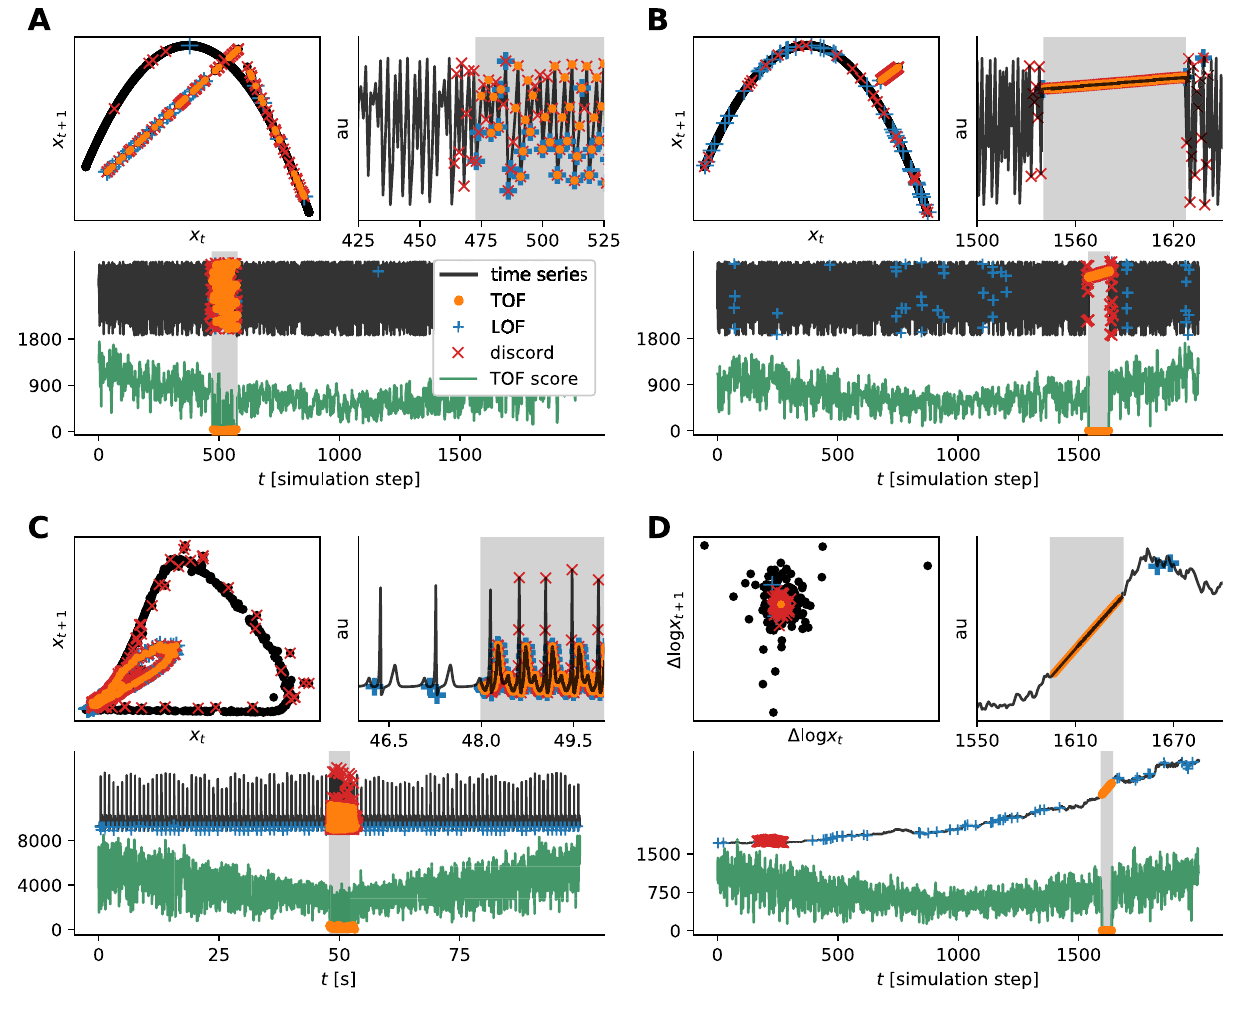
Figure 2. Detection examples on simulated time series with anomalies of different kinds. ( A ) Logistic map time series with tent-map anomaly. ( B ) Logistic map time series with linear anomaly. ( C ) Simulated ECG time series with tachycardia. ( D ) Random walk time series with linear anomaly, where TOF was measured on the discrete-time log derivative ( (cid:31) logx t ). Each subplot shows an example time series of the simulations (black) in arbitrary units and in three forms: Top left the return map, which is the results of the 2D time delay embedding and defines the dynamics of the system or its 2D projection. Bottom: Full length of the simulated time series (black) and the corresponding TOF values (green). Shaded areas show anomalous sections. Top right: Zoom to the onset of the anomaly. In all graphs, the outliers detected by TOF, LOF, and Keogh’s brute force discord detection algorithms are marked by orange dots, blue plus, and red x signs respectively. While anomalies form clear outliers on A and B, D shows an example where the unique event is clearly not an outlier, but it is located in the center of the distribution. All the three algorithms detected the example anomaly well in case A, TOF, and discord detected well the anomalies in B and C cases, but only TOF was able to detect all the four anomaly